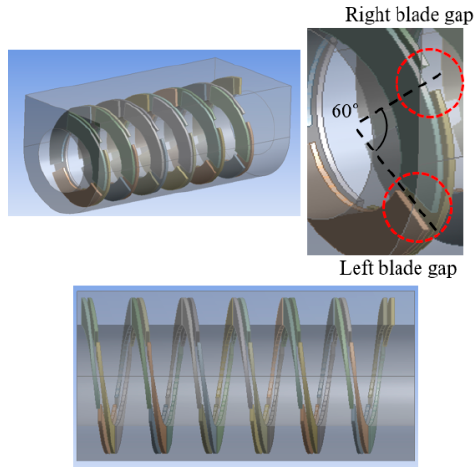
Figure 15. 3D model of double blade with gaps.